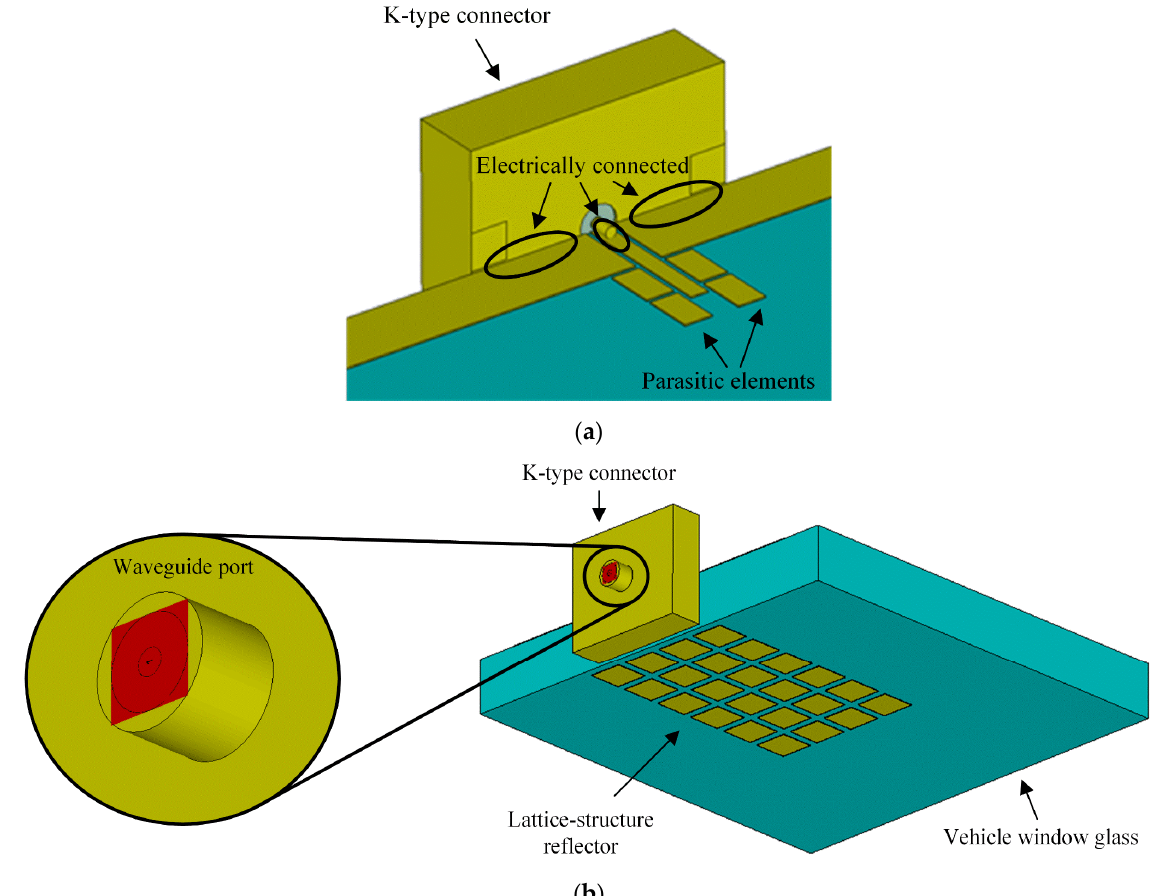
Figure 2. The actual connector model with a waveguide port in the CST EM simulation software: ( a ) a feeding connection part; ( b ) a waveguide port excitation part. Table 1. Optimized design parameters of the proposed antenna.